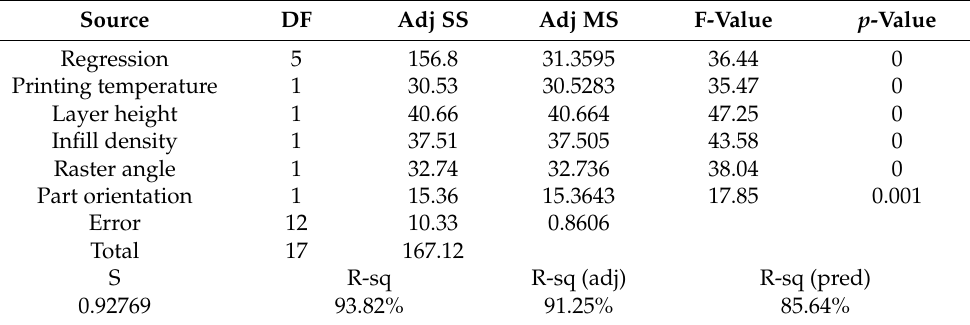
Table 6. Tensile test response